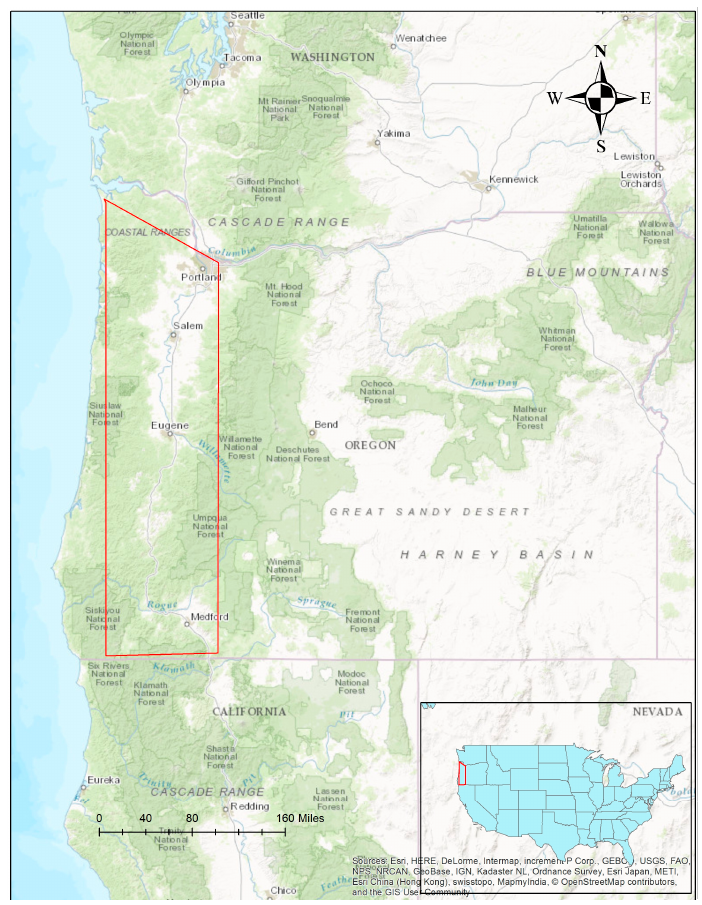
Figure 2. Geographical location of the selected site in the state of Oregon.